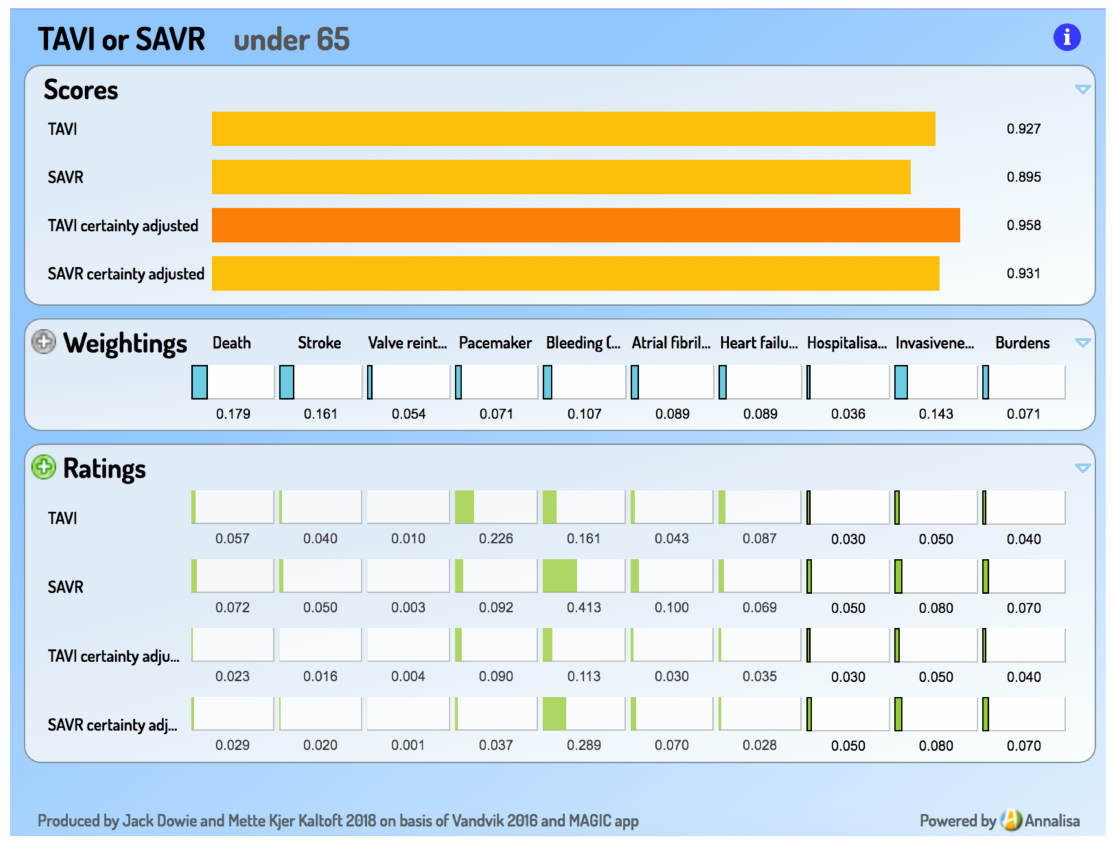
Figure 3. Screen capture from the MAGIC add-on decision support